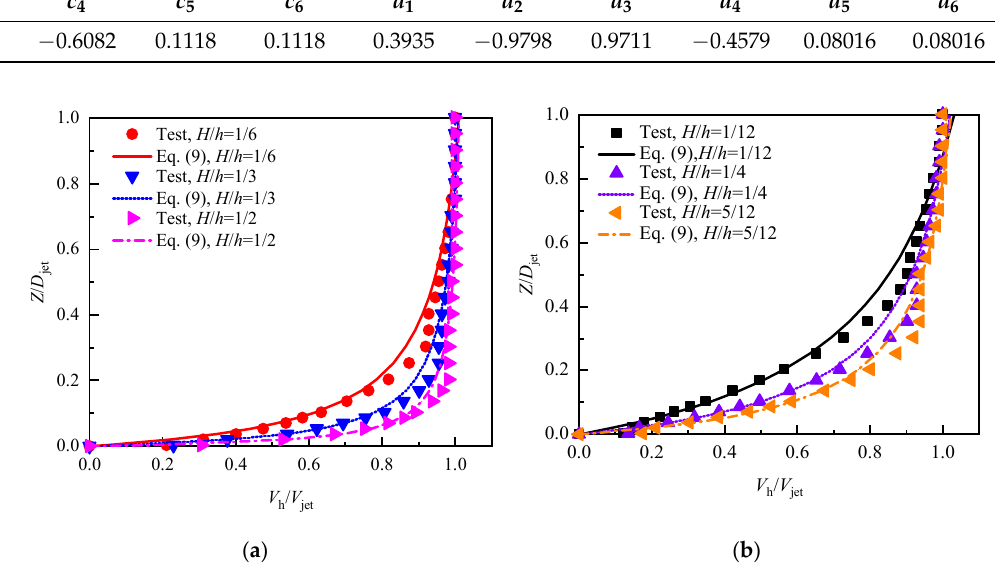
Figure 27. Experimental and predicted vertical wind velocities on crest ( r h = 0.0 D jet ). ( a ) L = 0.5 D jet ; ( b ) L = 1.0 D jet